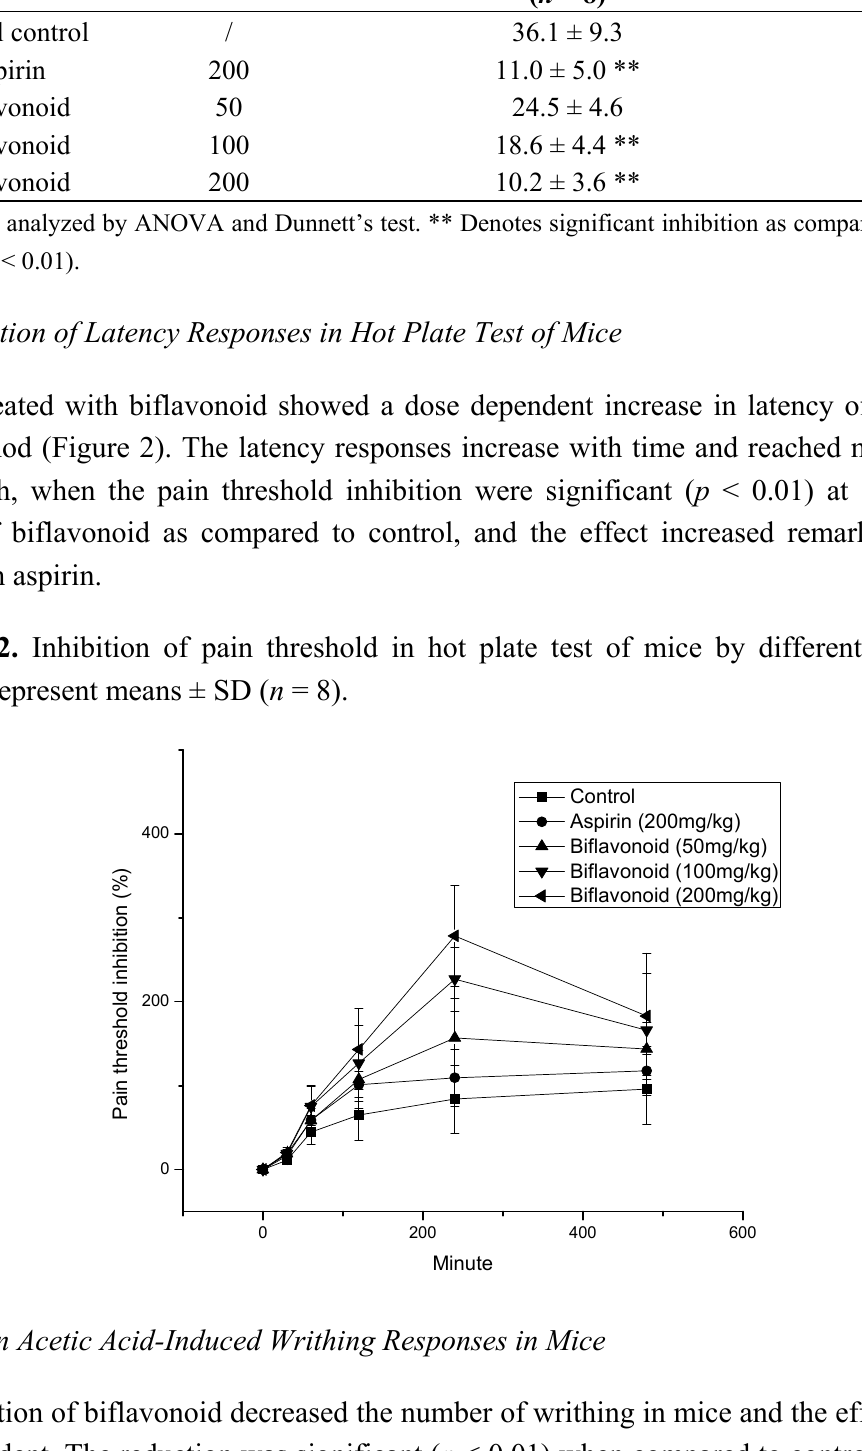
Table 3. Effect of the biflavonoid on croton oil induced ear inflammation in mice. Drug